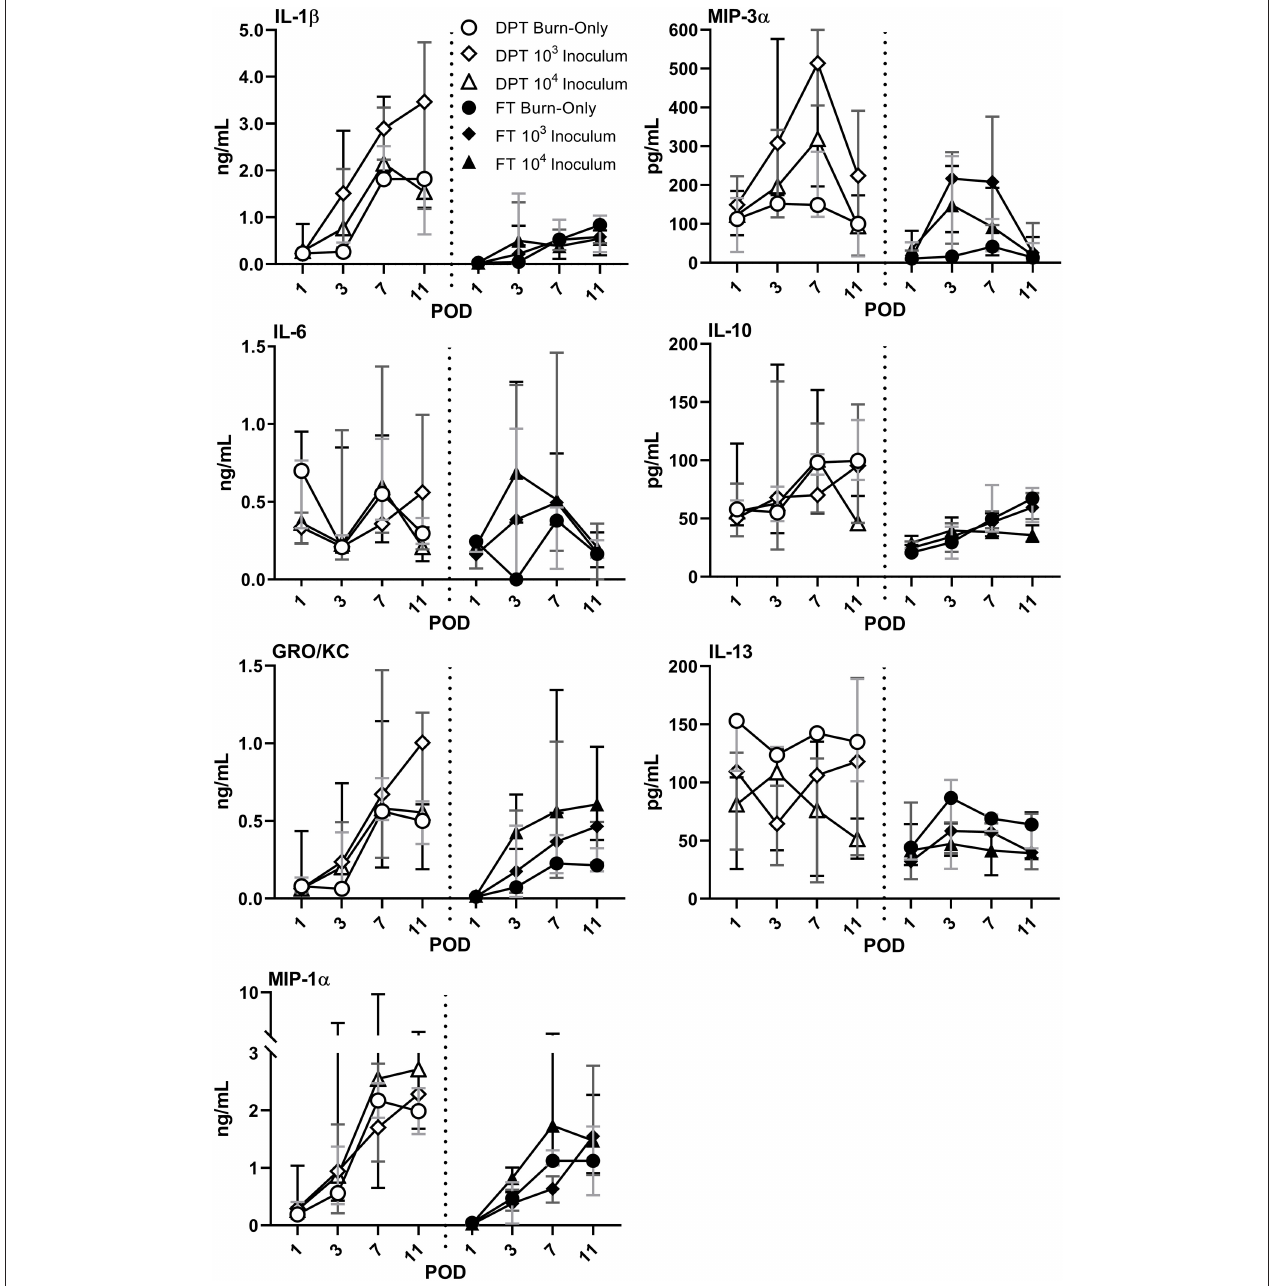
FIGURE 2 | Local cytokine & chemokine profile following DPT & FT injury. Burn injury alone induced elevations in both pro- and anti-inflammatory cytokines, with the exception of MIP-3 α in FT burn wounds. Relative to burn-only groups, infection with P. aeruginosa induced greater elevations in some pro-inflammatory cytokines, as well as MIP-3 α in both DPT and FT burns. However, anti-inflammatory cytokines IL-10 and IL-13 were inhibited by the infection. Gray, dark gray, and black bars represent the interquartile ranges of burn-only, 10 3 inoculum, and 10 4 inoculum, respectively.